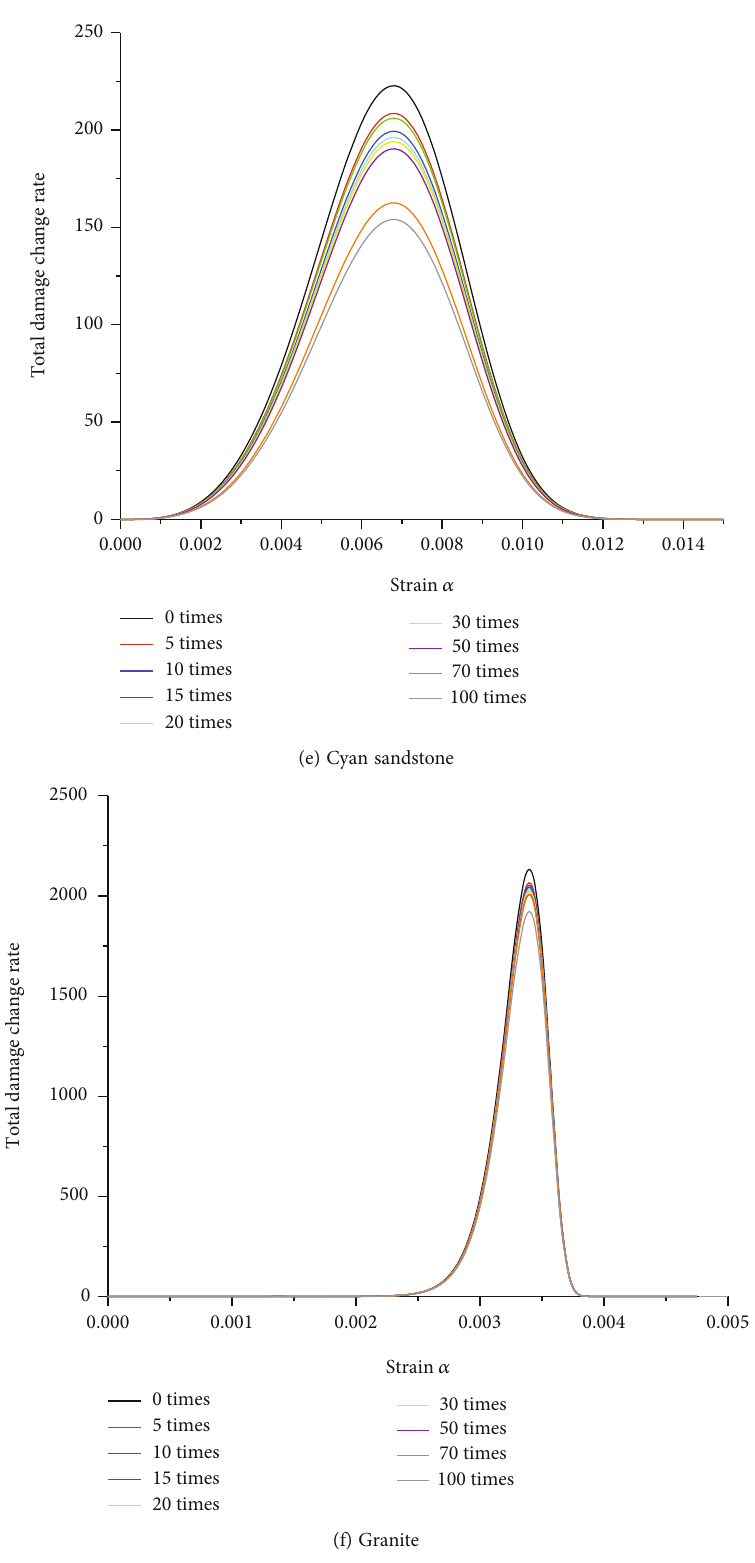
Figure 12: Variation curves of freeze-thaw damage model and damage rate of three types of